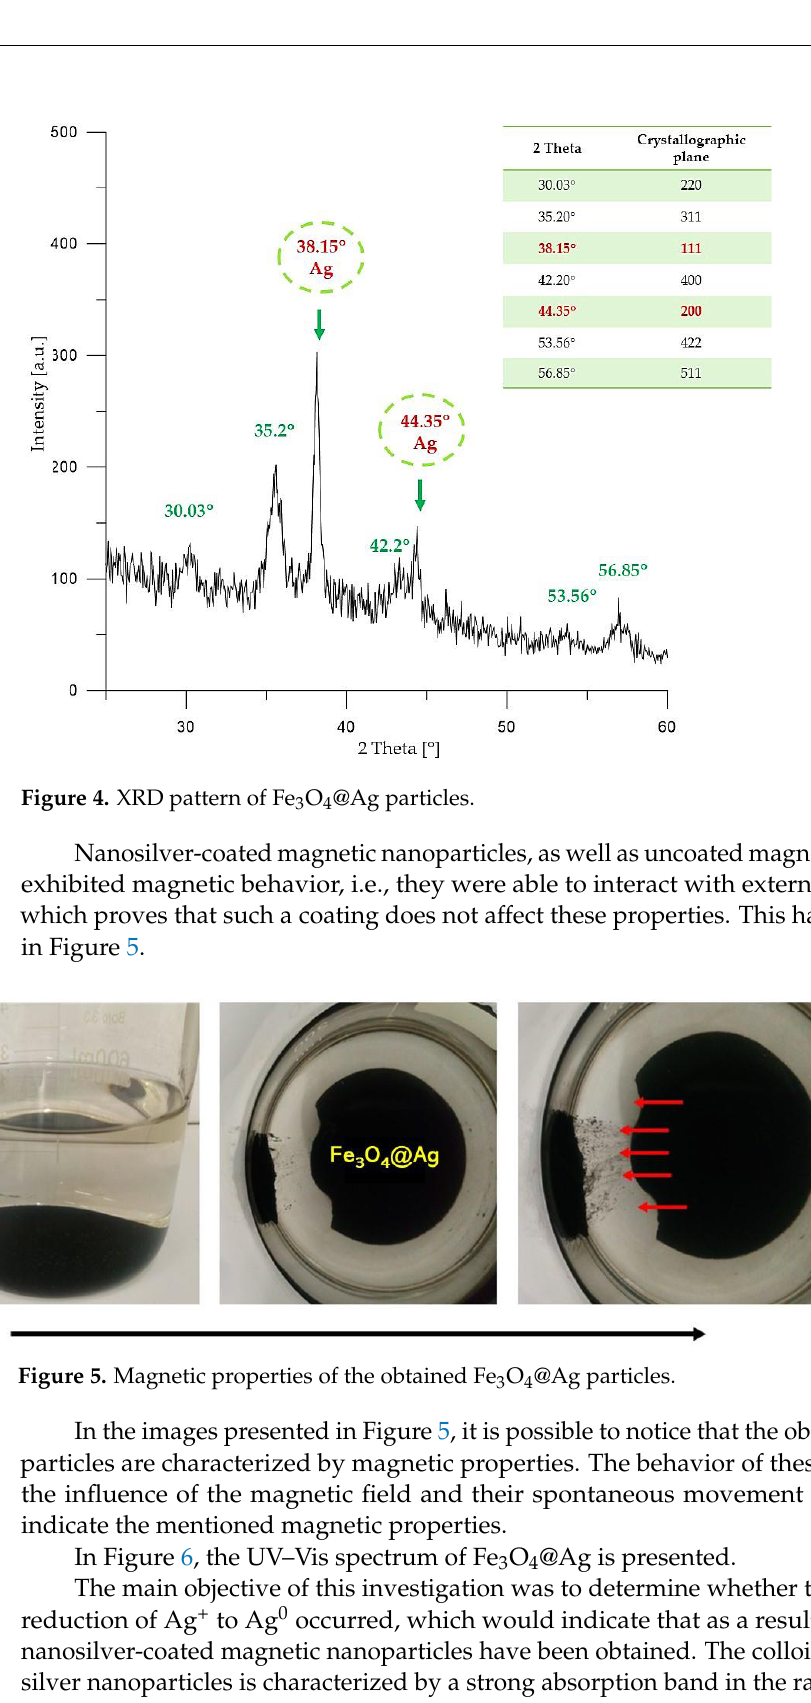
Figure 6. UV – Vis (Ultraviolet Visible Spectroscopy) spectrum of Fe 3 O 4 @Ag particles. The main objective of this investigation was to determine whether the reaction of the reduction of Ag + to Ag 0 occurred, which would indicate that as a result of the synthesis, nanosilver-coated magnetic nanoparticles have been obtained. The colloidal suspension of silver nanoparticles is characterized by a strong absorption band in the range of ultra- violet and visible radiation, which is caused by the phenomenon of surface plasmon res- onance. This collective oscillation and the excitation of the outermost electrons on the sur- face of nanoparticles resulted in the appearance of a characteristic, intense color of the colloidal solution. The location of the maximum absorption range depends, for example, on the type of nanoparticles, their size, and shape. The maximum absorbance of silver nanoparticles occurs in the range of 380 – 450 nm [46,47]. On the obtained UV – Vis spectrum, an absorbance maximum at 436 nm can be ob- served. Therefore, it may be reported that such a value is in the previously mentioned